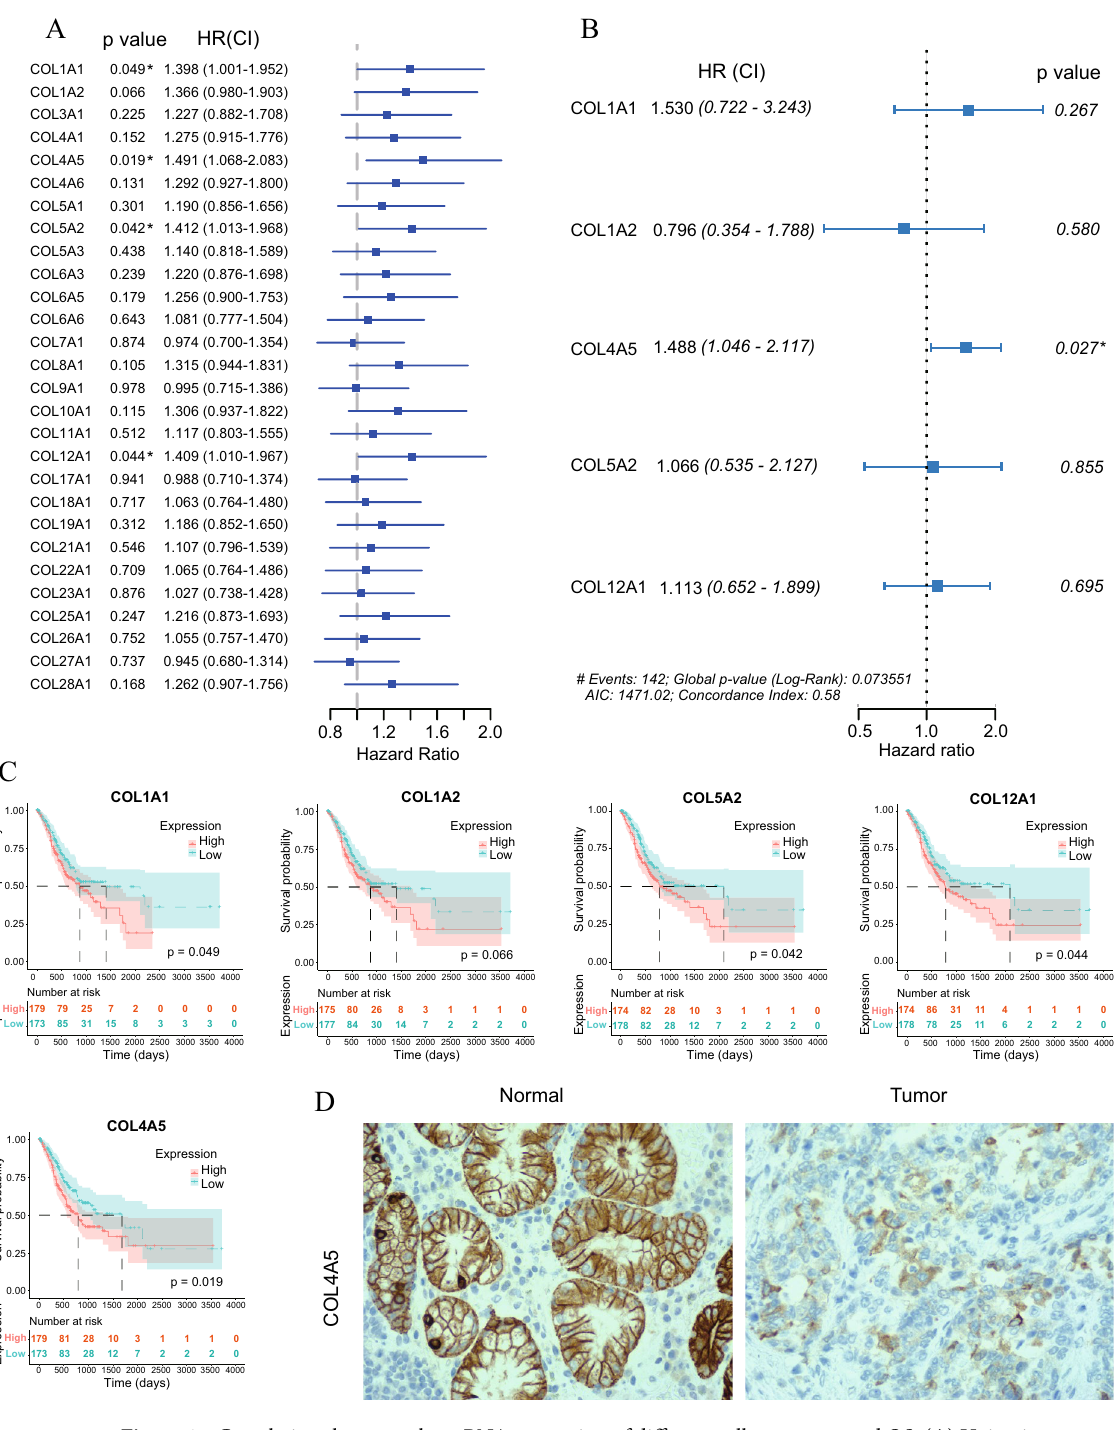
Figure 1. Correlations between the mRNA expression of different collagen genes and OS. ( A ) Univariate analysis. ( B ) Multivariate analysis for genes with p < 0.1 in the univariate analysis. ( C ) Kaplan–Meier survival curves for the five collagen genes with p < 0.1 in the univariate analysis. ( D ) Representative images of immunohistochemical staining for COL4A5 expression in GC tumor and normal tissues (400×). Unless specified, throughout this essay, the statistical significance was annotated by the number of stars (*: P-value < 0.05; **: P-value < 0.01; ***: P-value < 0.001; **** P <